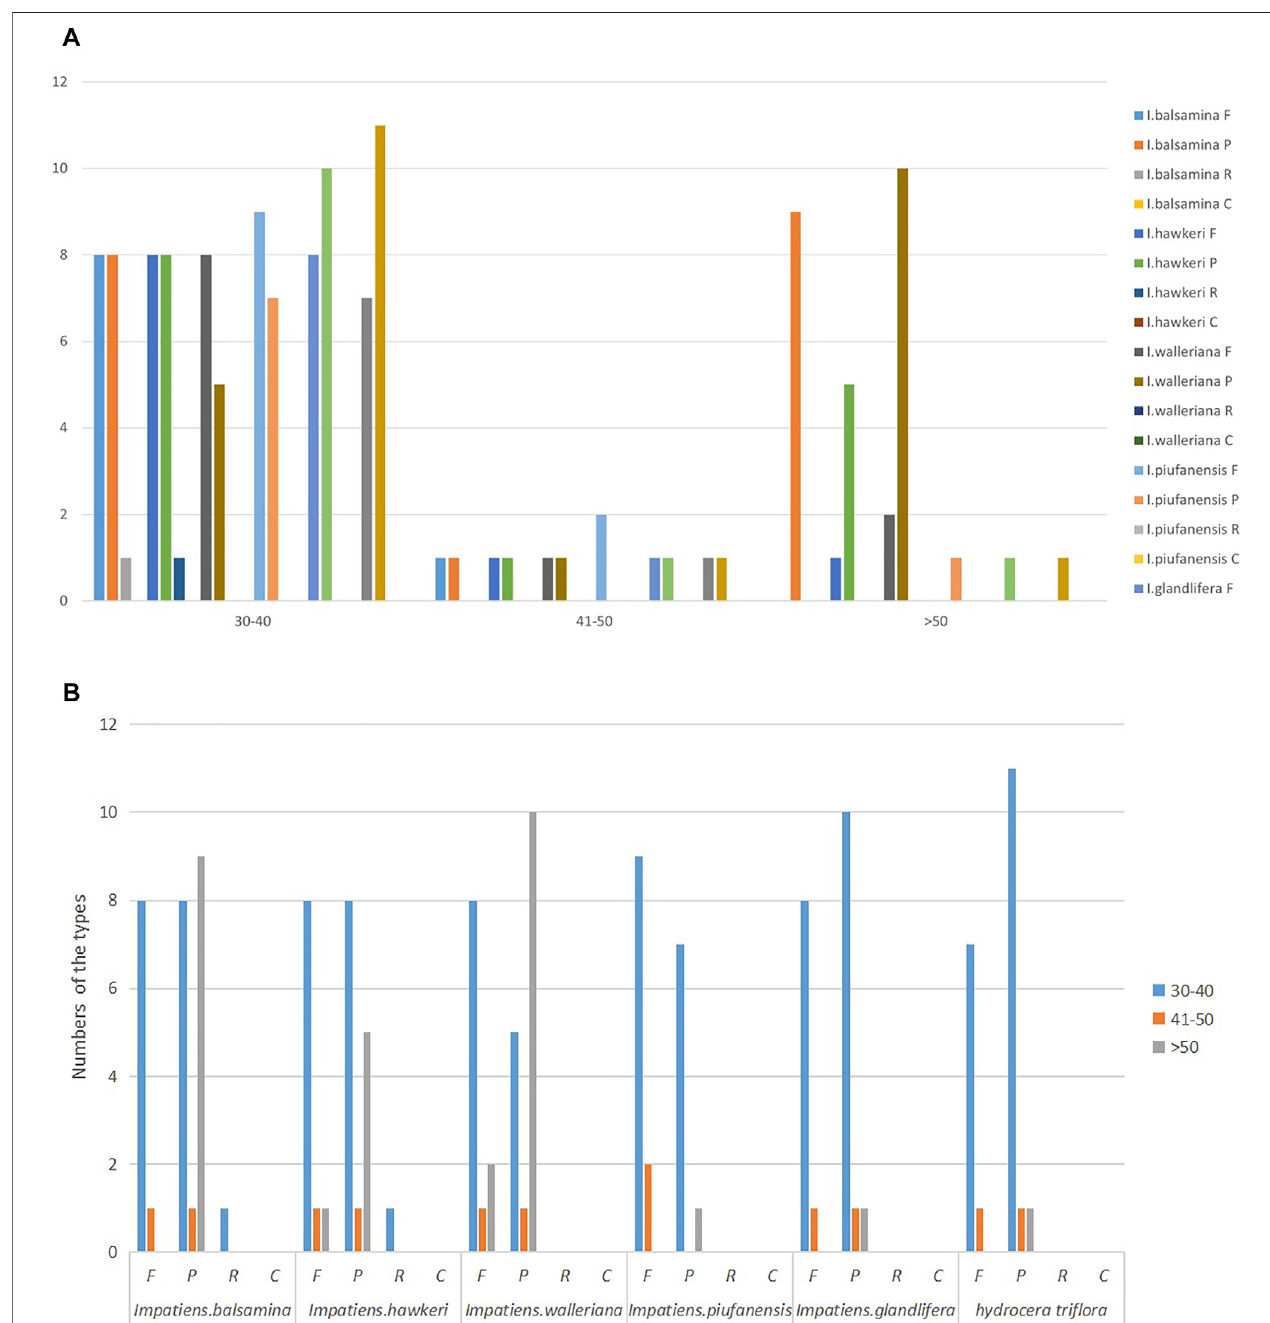
FIGURE2| Analysisofrepeatedsequencesinthe I.balsamina,I.hawkeri, I.walleriana, I.piufanensis, I.glandulifera, and H.tri fl ora chloroplastgenomes. (A) Atotal of six species of four repeat types by length; (B) Total six species of four repeat types.